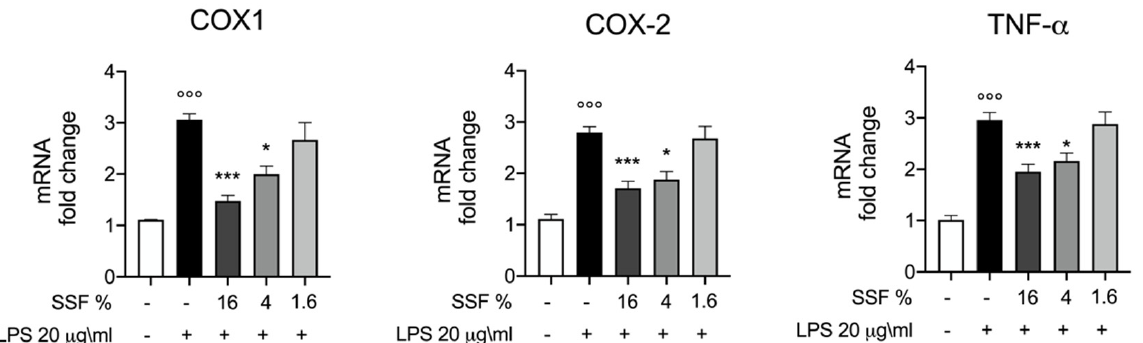
Figure 3. Protective effect of SSF in LPS-induced intoxication in CPEK cells: mRNA levels of COX1, COX2 and TNF-alfa one hour post LPS stimulation and SSF treatment. Data representative of at least three experiments, ◦◦◦ p < 0.001 versus CTR; * p < 0.05 versus LPS; *** p < 0.001 versus LPS.